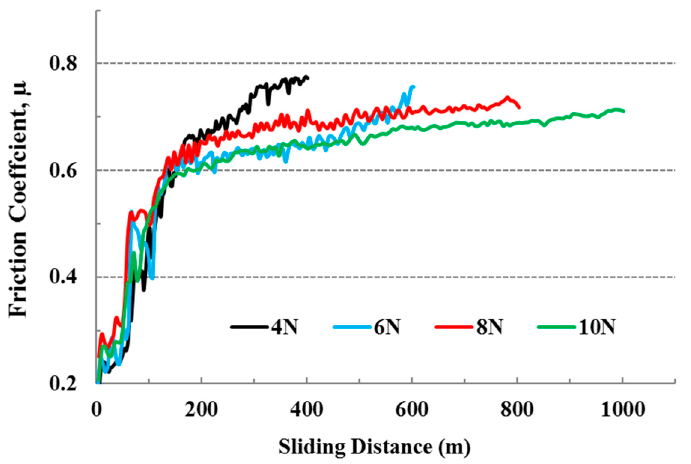
Figure 6. Variation in friction coefficient vs. sliding distance for as-sprayed Cu-10Sn under different loading conditions.